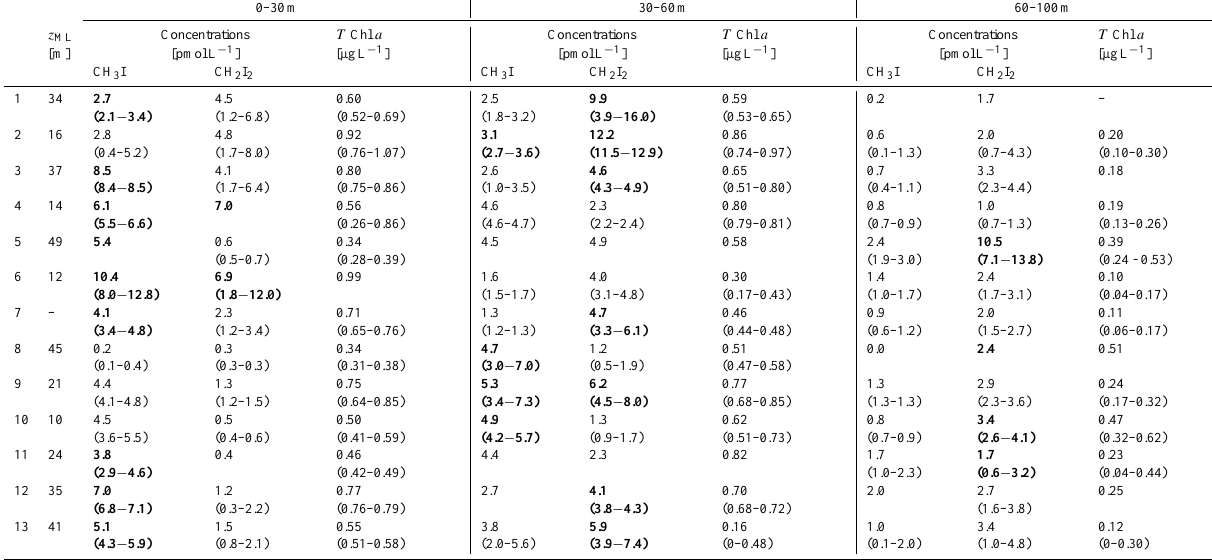
Figure 5. Principal component analysis (PCA) of halocarbon and phytoplankton species composition data, as well as temperature, salinity, and density for the 13 CTD stations during MSM18/3. Table 4. Concentrations of CH 3 I, CH 2 I 2 and the sum of T Chl a averaged over different depths at every CTD station (1–13), as well as the mixed layer depth. If a range is not given, only one measurement point exists. Bold numbers indicate the depth of maximum concentrations at this